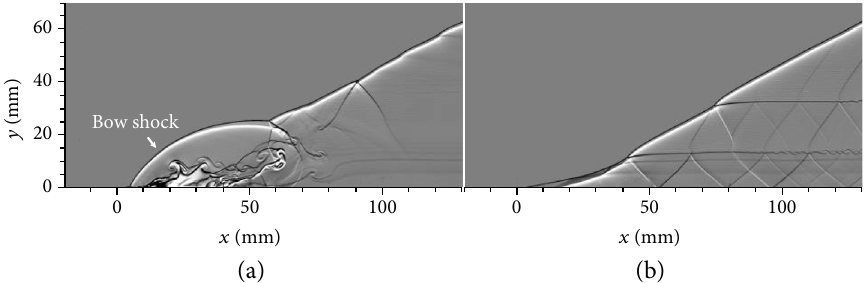
Figure 9: Evolution of the fl ow fi eld after DJFD of 500 Δ t at θ = 31 ∘ . (a) t = 500 Δ t (the jet fl ow has just been turned o ff ) and (b) steady state after the disturbance.